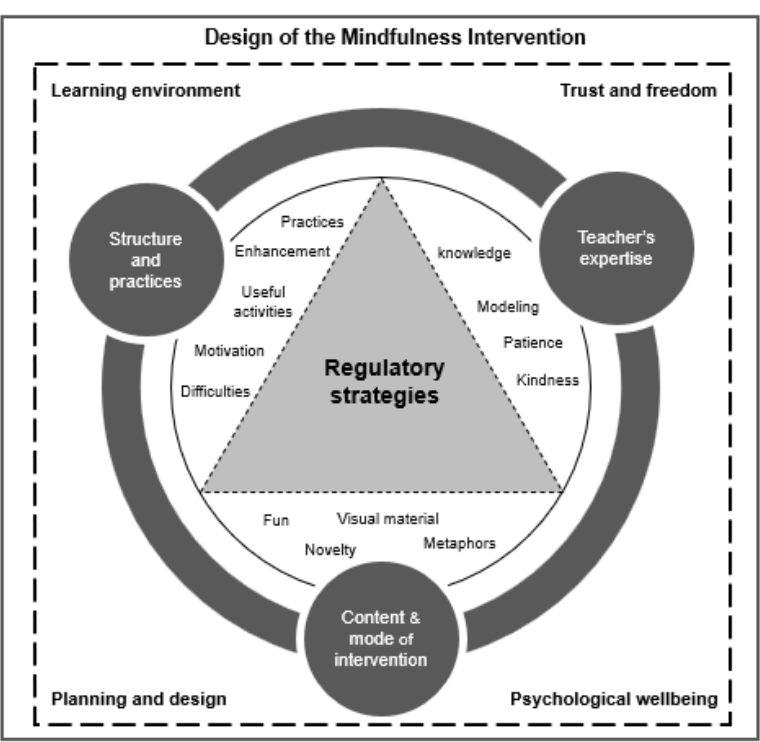
Figure 2. Model of mindfulness-based intervention for adolescents.